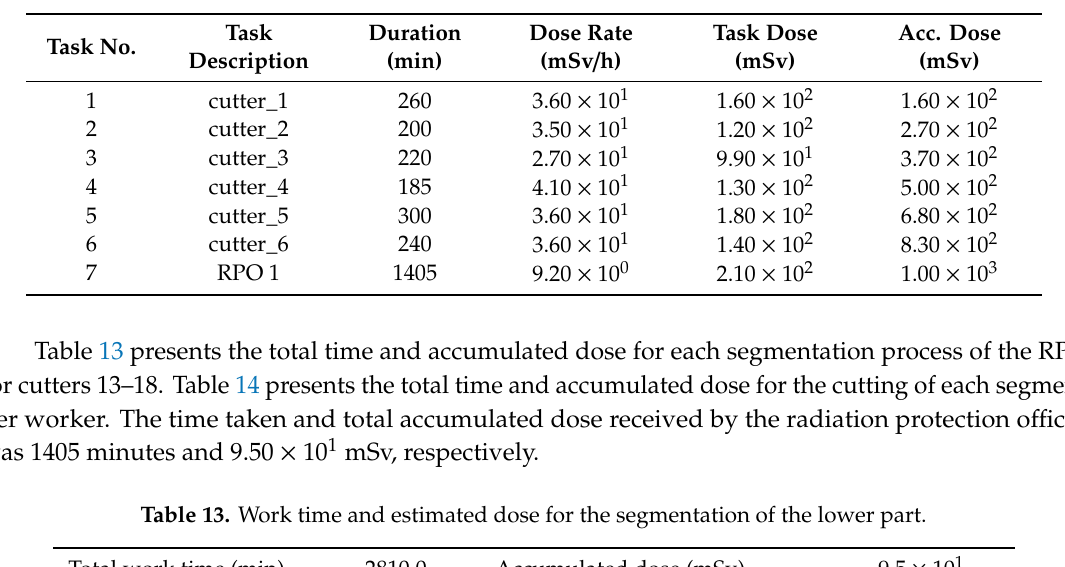
Table 12. Task information for the segmentation of the active part.